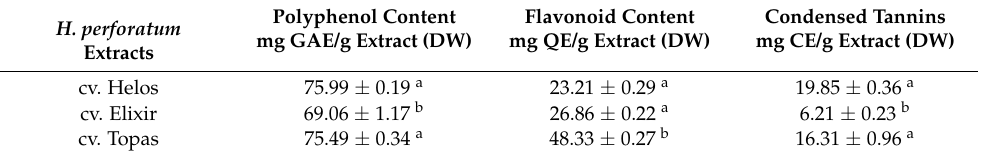
Table 1. Content of total phenolics (calculated as gallic acid), total flavonoids (calculated as quercetin), and condensed tannins (calculated as catechin) in the methanolic extracts from the biomass of in vitro agitated cultures of the H. perforatum cultivars Helos, Elixir, and Topas (MS, 0.1 mg/L BAP and 0.1 mg/L NAA, 5